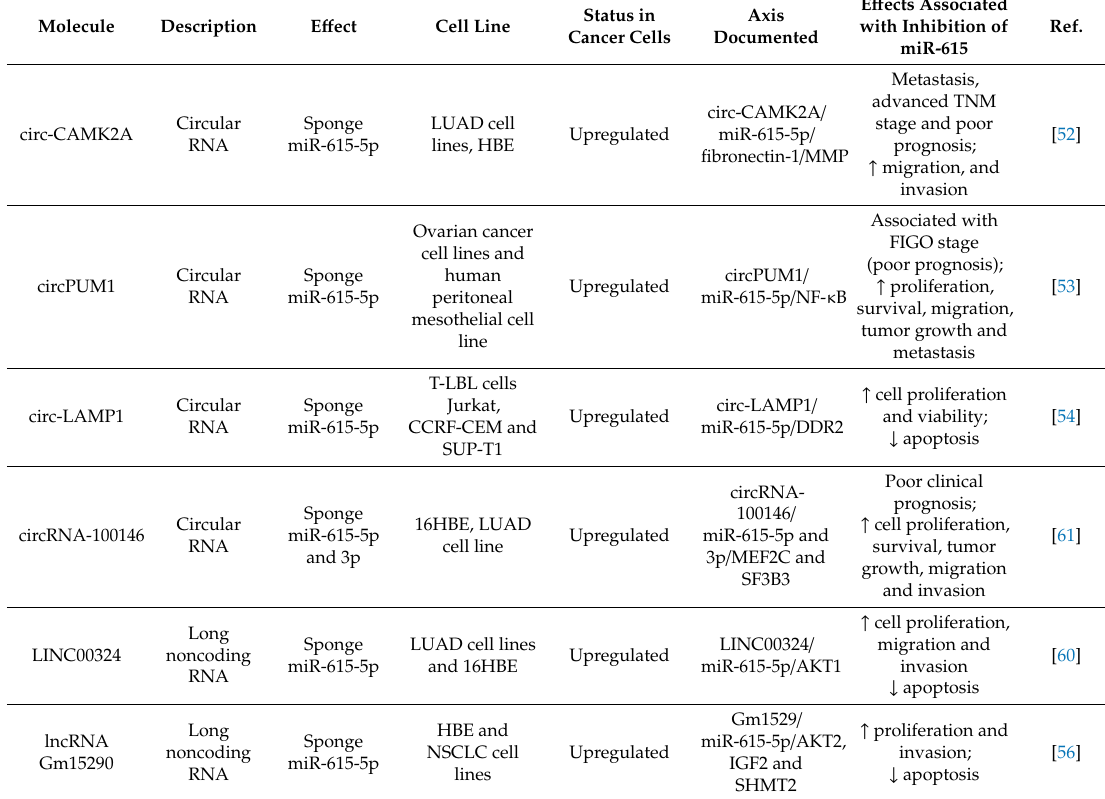
Table 3. Inhibitory molecules of miR-615 3p and